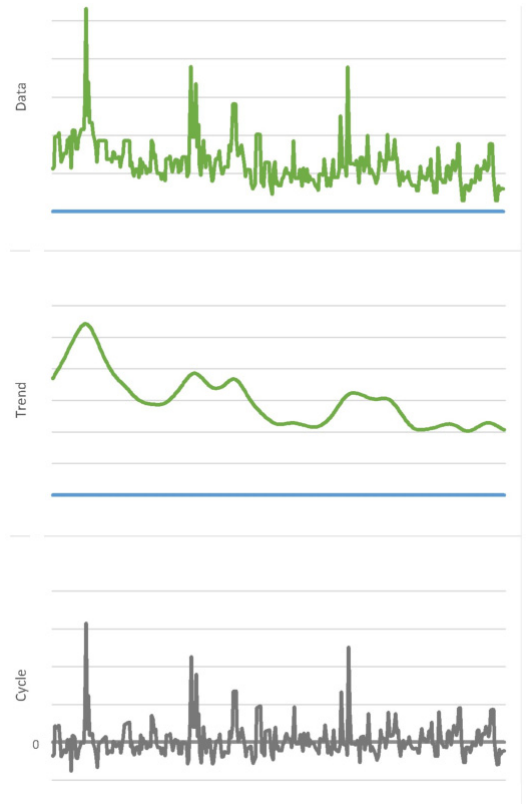
Figure 3. A dataset segregated into trend and cycle components after applying the FMHP filter.